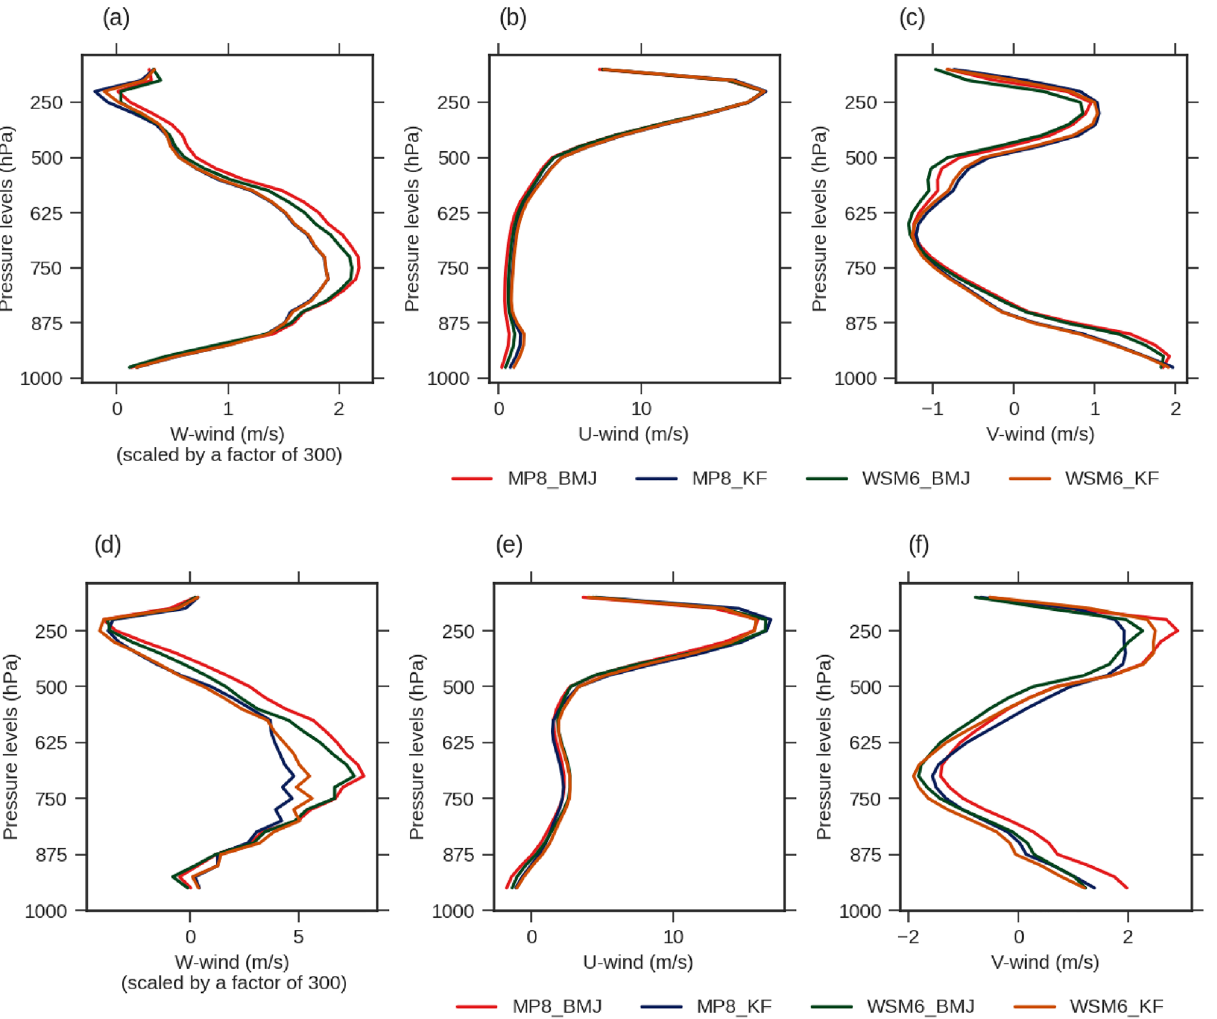
Figure 9. The areal and temporal averaged U ( b , e ), V ( c , f ), and W ( a , d ) wind components varying with vertical levels. These averaged wind components over vertical levels are shown for WRF experiments; MP8_BMJ, MP8_ KF, WSM6_BMJ, and